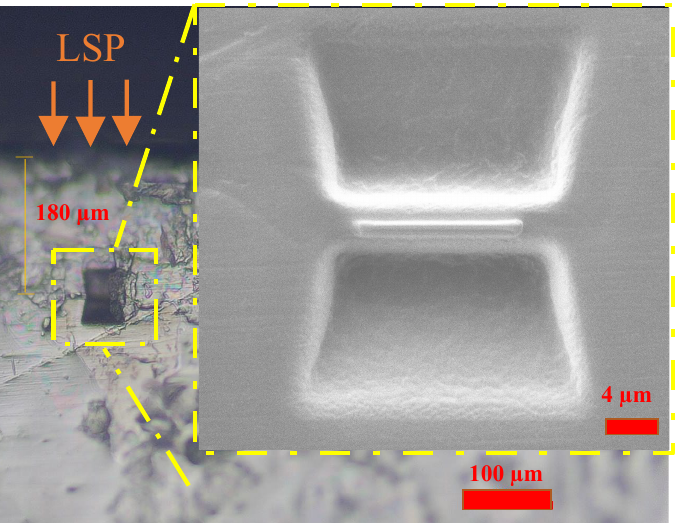
Figure 3. The position of the TEM lamella sample using the in situ lift-out FIB method.